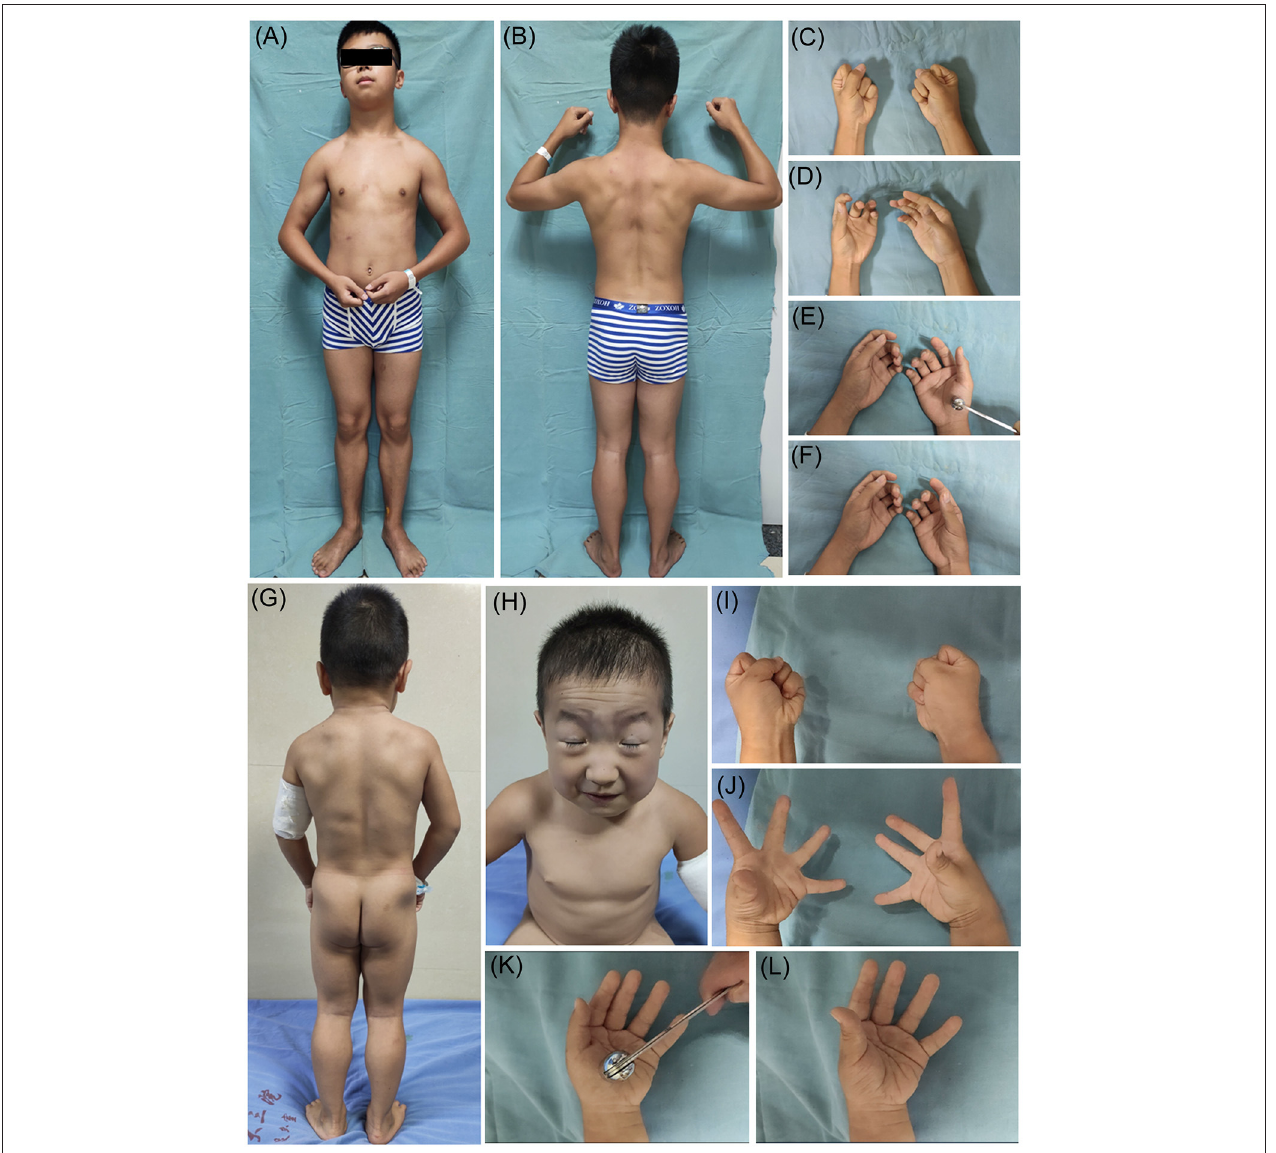
FIGURE 1 | Clinical features of non-dystrophic myotonia. Patient 17 (myotonia congenita): (A,B) show muscle stiffness and hypertrophy; (C,D) show grip myotonia; (E,F) show percussion myotonia. Patient 20 (paramyotonia congenita); (G) shows muscle stiffness and hypertrophy; (H) shows facial stiffness and eye closure myotonia; (I,J) show grip myotonia; (K,L) show percussion